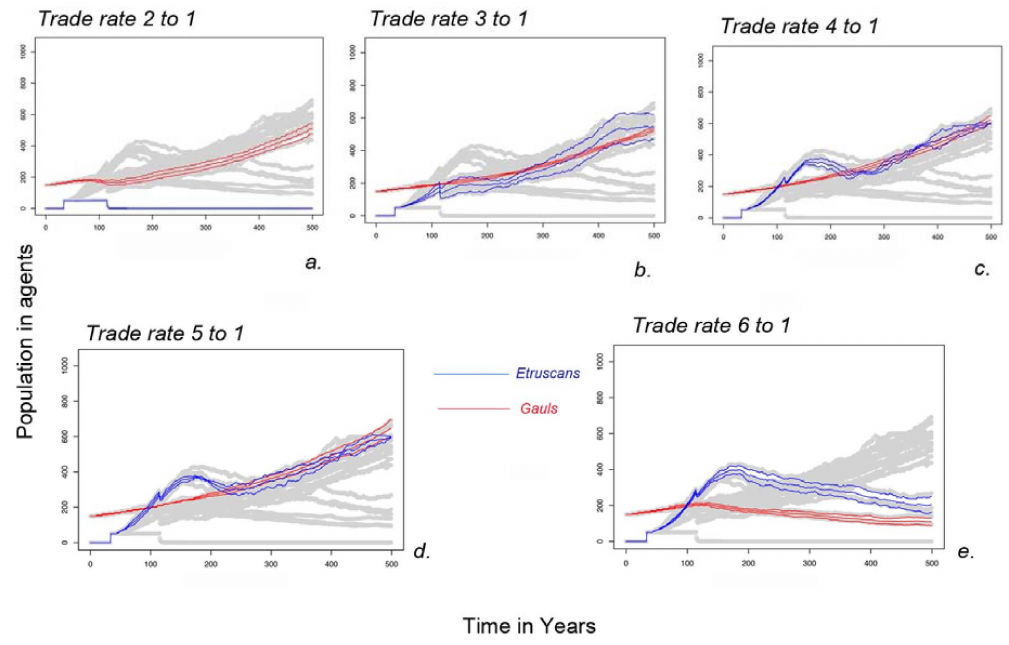
Figure 3. Population response in the simulation, tied to the consumption of grain (grey lines). Solid lines denote the mean population for the scenario being examined, dotted lines denote one standard deviation of the mean above and below the mean. Scenarios a through e represented different trade rates examined in this